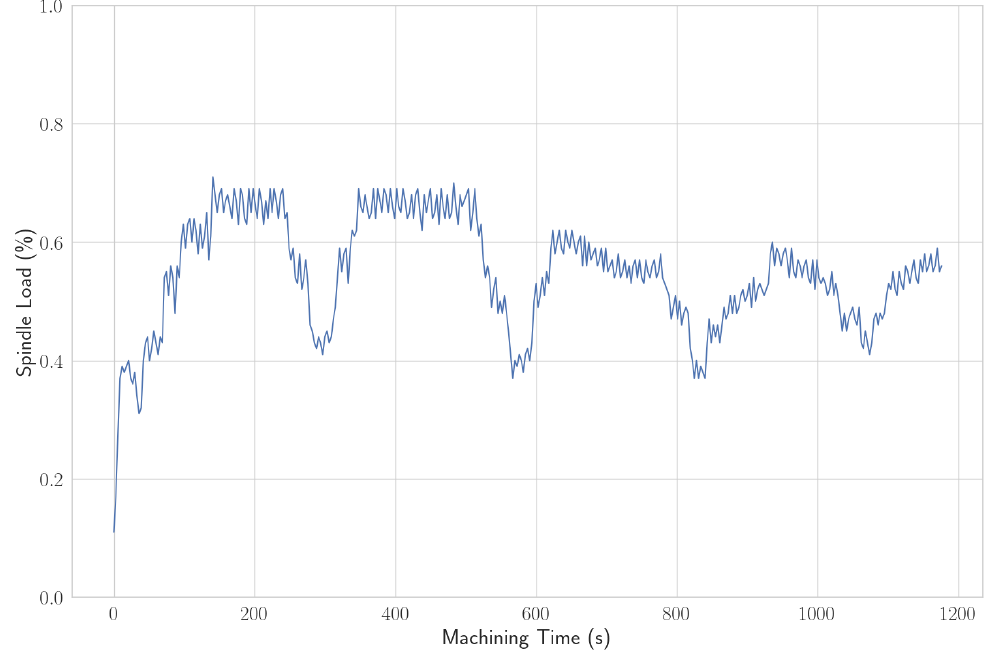
Figure 5. Raw data for the program 1543 and tool 6040 on the T5-1 machine for run